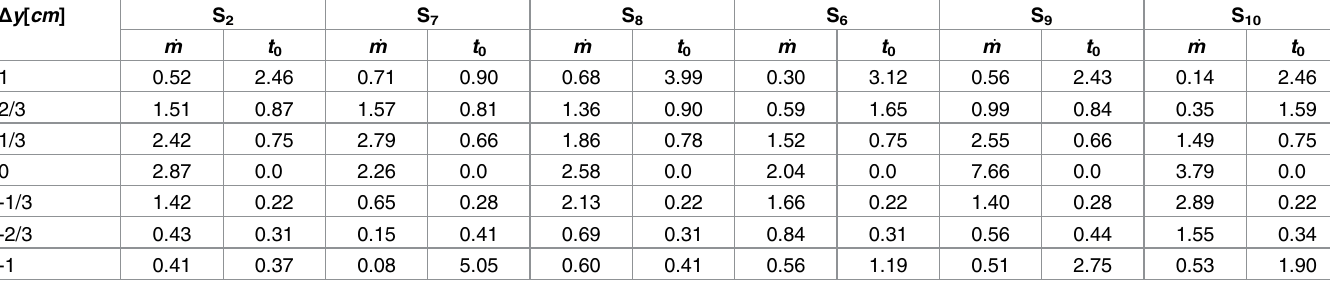
Table 4. Drug accumulation rate (1/s) and appearanceinstant (s), as obtained by varying the catheter angle. Δ y [ cm ] S 2